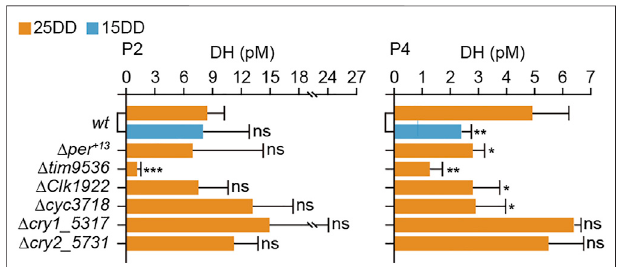
FIGURE3| Diapausehormone(DH)concentrationinhemolymphduring pupal-adult development in clock gene knockout mutants. Both wt and knockout mutants ’ eggs were incubated under constant darkness (DD) at 25 ° C (25DD), and only wt eggs were incubated under DD at 15 ° C (15DD). Hemolymph was collected at 2 (P2) and 4 (P4) days after pupation. Each bar represents mean ± standard deviation (SD) of fi ve samples. Statistical differenceswere examined by Student ’ s t -test between wt at 15DD or each knockout mutant and wt at 25DD. ns, non-signi fi cant; *, p < 0.05; **, p < 0.01; ***, p <